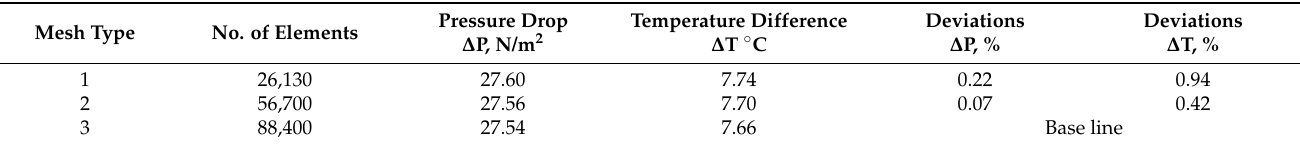
Table 1. Grid independence